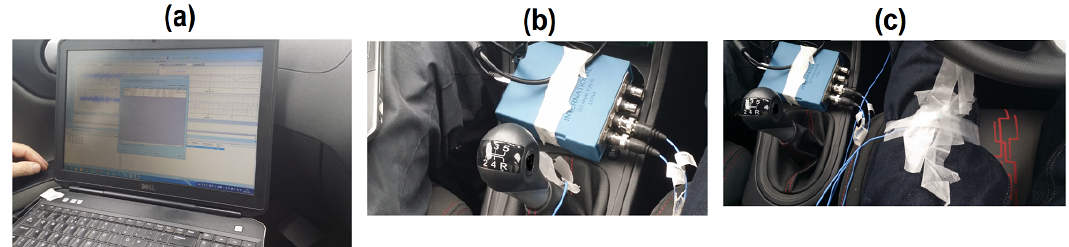
Figure 8. Test set up: ( a ) standard laptop with the signal processing tool “m+p Analyzer”, ( b ) NI 9234 module for measurement, and ( c ) Dytran 3055 sensor mounted on human driver thigh.